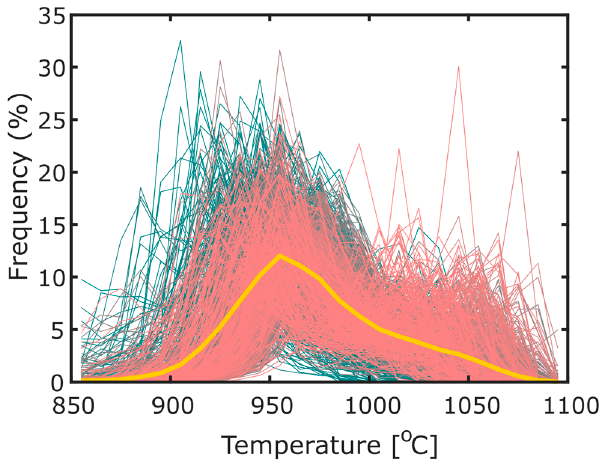
Figure 9. Histograms of temperature distributions, in 10 °C bins, across the lava lake from 18:12:20 to 18:44:48 UTC on 12 June 2017. The lava lake area was defined by a user-defined region of interest. For clarity, histograms are coloured by the frame time they represent; earlier frames are more blue and later frames are more red. The bold yellow line represents the mean distribution, which is a slight positive skew. This is likely due to bubble bursts and lake turbulence which introduce hotter lava into what otherwise would be a steadily cooling crust which you may expect to display a Gaussian temperature distribution.